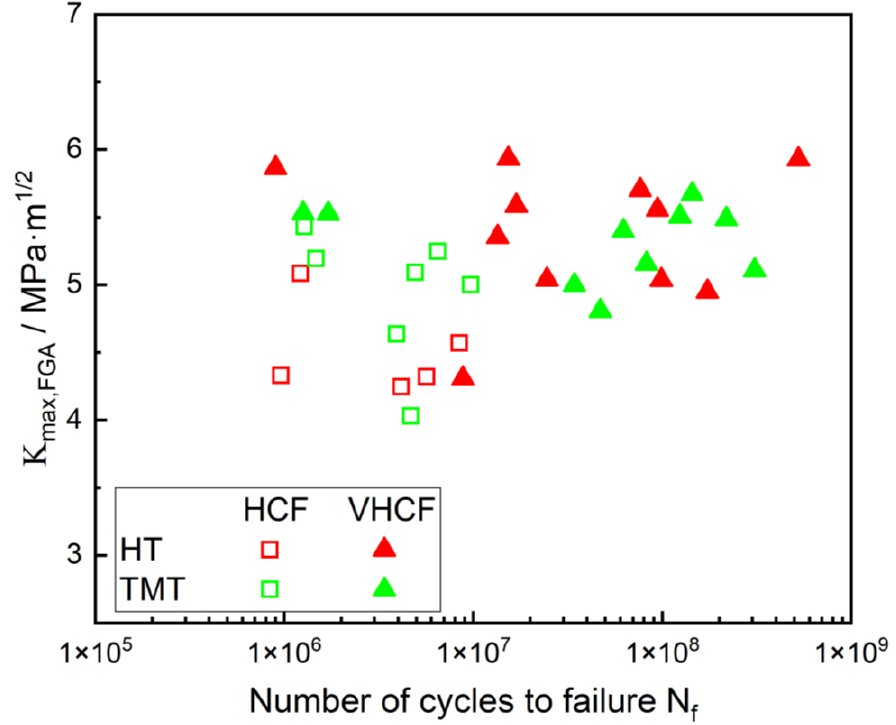
Figure 9. Maximum stress intensity factor at the border of FGA K max,FGA for the HT and TMT specimens.